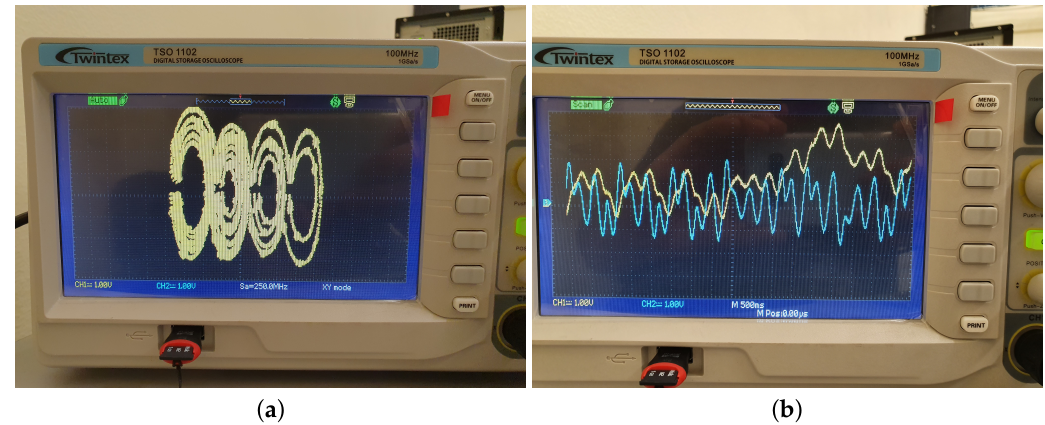
Figure 4. Acquired data from the master system: ( a ) Projection on the plane ( χ 1 , χ 2 ). ( b ) χ 1,2 vs t .